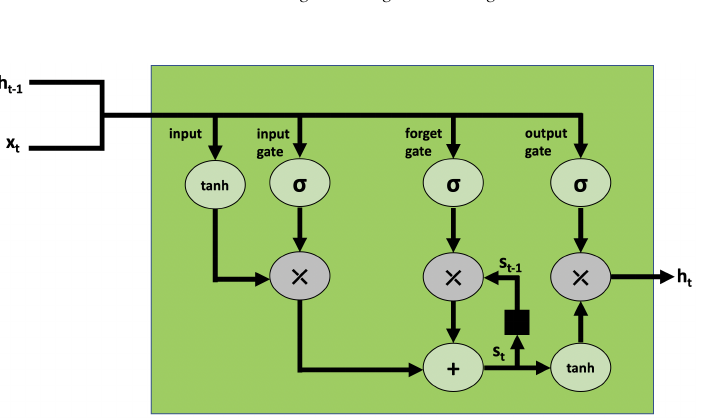
Figure 4. Long short-term memory (LSTM) cell